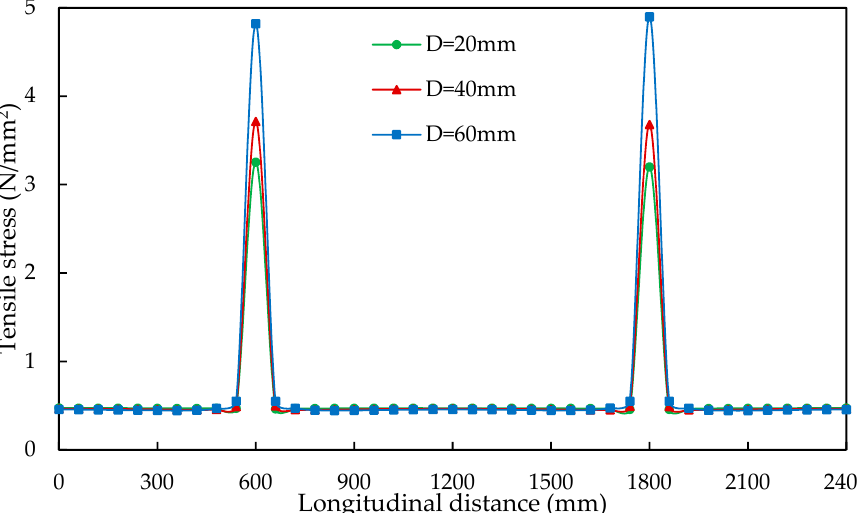
Figure 11. Comparison of maximum concrete tensile stress over the saw-cut tips along the length of concrete slab for different saw-cut depths.